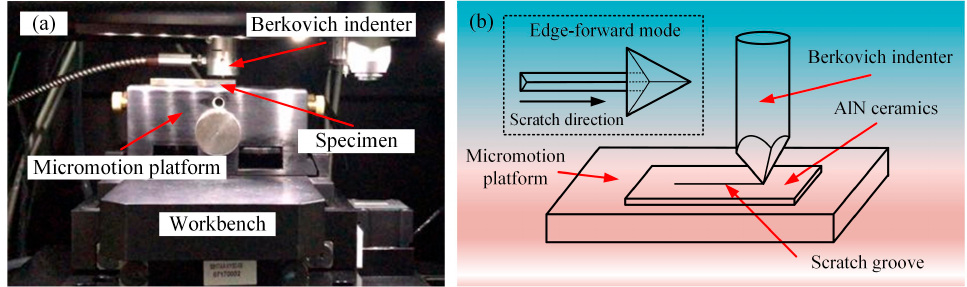
Figure 1. ( a ) G200 nanoindentation instrument ( b ) Outline of scratch tests.